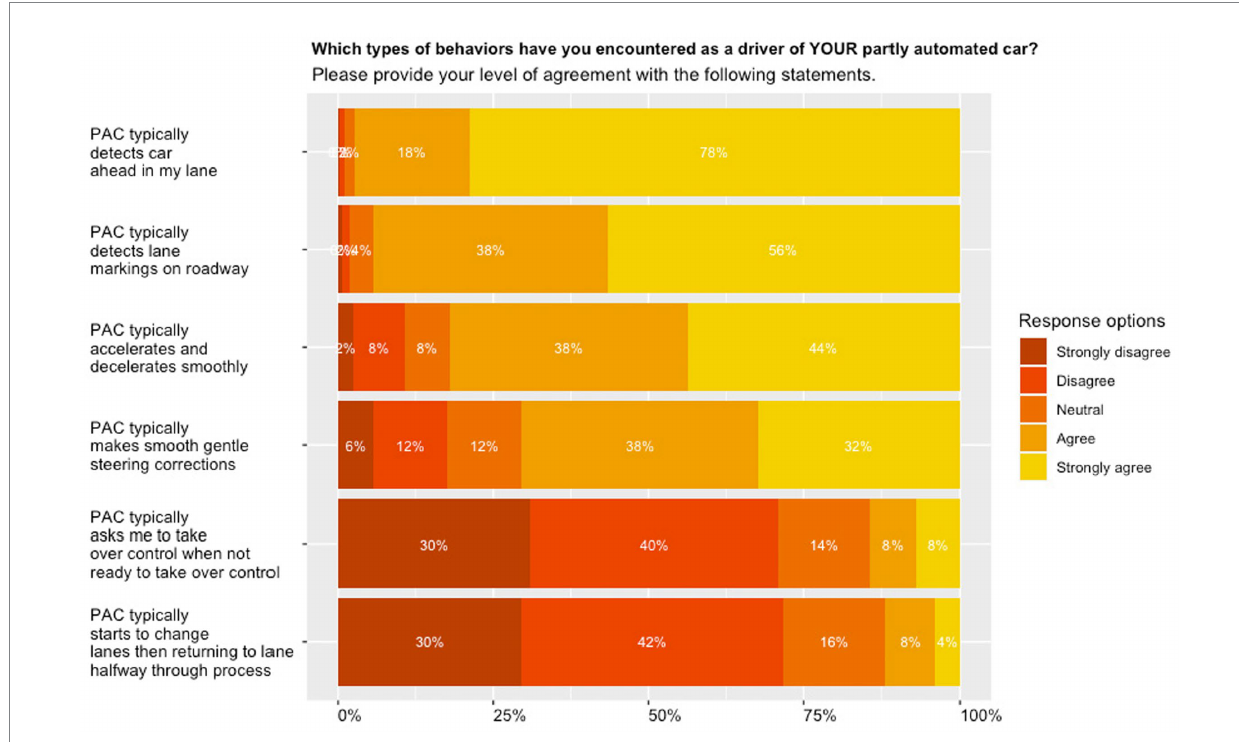
FIGURE 3 System performance; stacked bar plots presenting relative proportions of questions pertaining to system performance sorted from highest (top) to lowest (bottom). PAC = partially automated